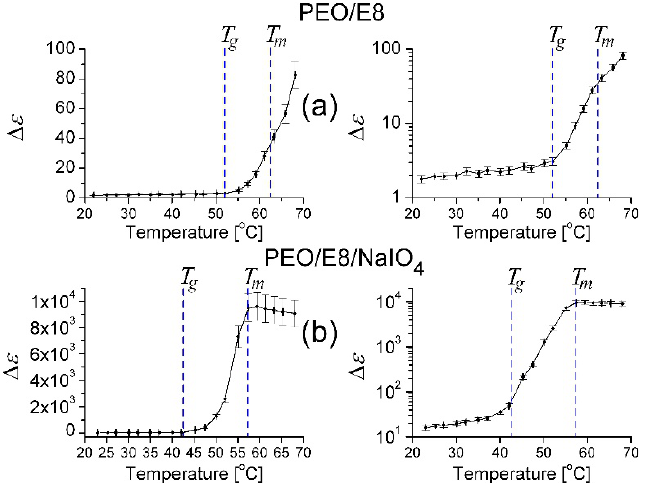
Figure 10. Plots of dielectric relaxation strength Δ ε vs. temperature. Data for PEO/E8 ( a ) and PEO/E8/NaIO 4 ( b ), in linear ( left ) and logarithmic ( right ) scales. The dashed lines point out the values of glass transition temperatures ( T g ) and melting temperatures ( T m ) for both composites. The error bars indicate the uncertainty of the calculated Δ ε values discussed in the text.